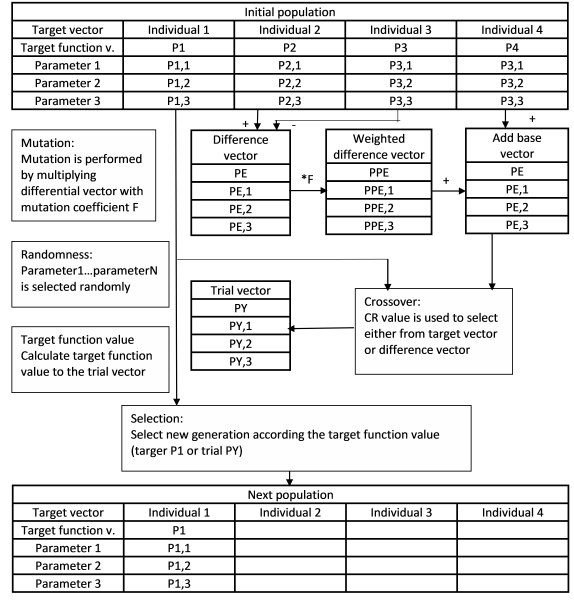
Figure 1: The differential evolution algorithm (DE/rand/1/bin)